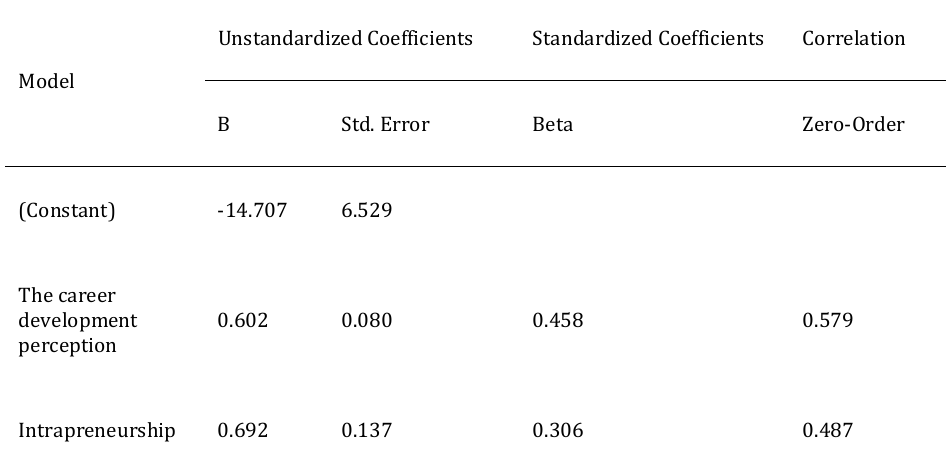
Table 15 The effective contribution of the intrapreneurship variable and the career development perception